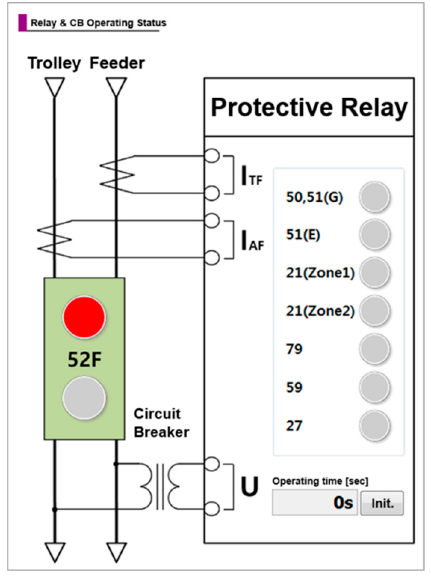
Figure 9. Output of protection element information for protective relay.